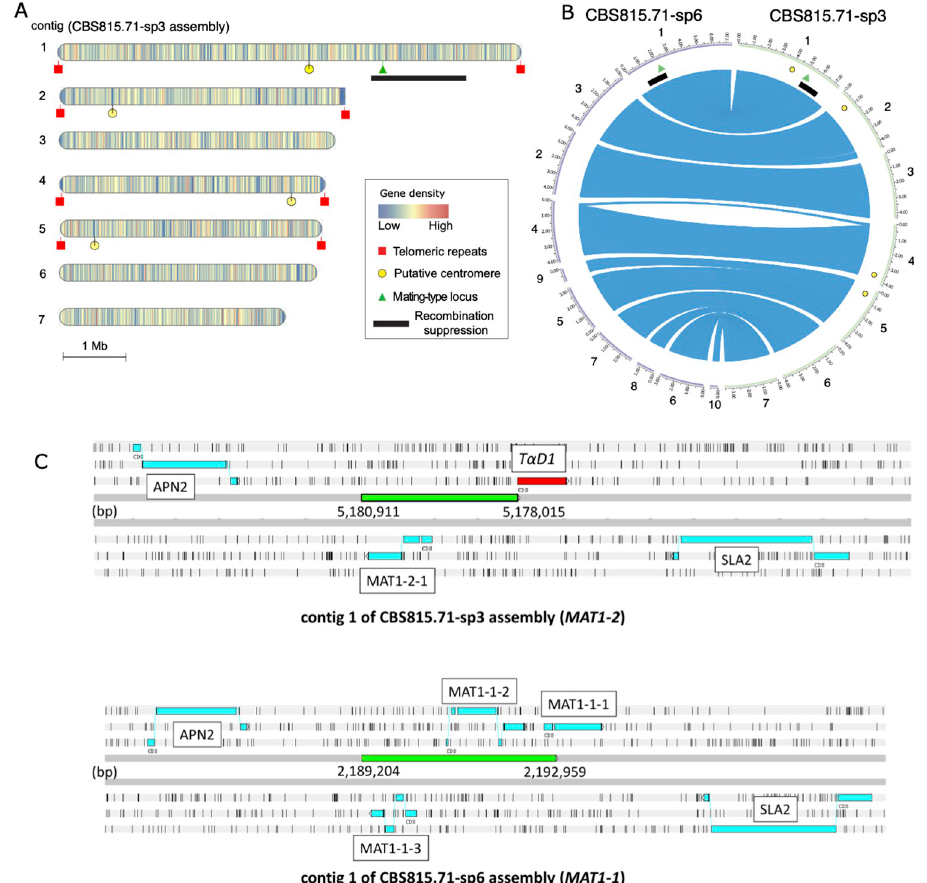
Fig 4. Genome features and annotation of the mating-type locus in the Schizothecium tetrasporum CBS815.71 strain. A. Ideograms representing the seven largest contigs of the CBS815.71-sp3 genome assembly. The mating-type locus is indicated with a green triangle, telomeric repeats with red boxes and putative centromeres with yellow circles. Gene density in 10 kb non-overlapping windows is represented by vertical bars on the contigs and the heatmap colors indicate low to high density. The non-recombining region around the mating-type locus is indicated by a black rectangle. B. Genome collinearity between opposite mating types of the Schizothecium tetrasporum CBS815.71 strain. Circular plot showing contigs from the CBS815.71-sp3 genome (green, right) and the CBS815.71-sp6 genome (purple, left). Only the largest contigs ( > 500 kb) were plotted. Blue links indicate the locations of orthologous genes (Mb). The mating-type locus is indicated with a green triangle. Putative centromeres and the non-recombining region around the mating-type locus identified on the CBS815.71-sp3 genome assembly are indicated by yellow circles and a black rectangle, respectively. C. Organization of the mating-type locus in CBS815.71-sp3 (top, MAT1-2 ) and CBS815.71-sp6 (bottom, MAT1-1 ) assemblies viewed in Artemis v18.0.2 [125]. The APN2 and SLA2 genes flanking the mating-type locus are indicated. The green boxes represent the nucleotide sequences differing between the two idiomorphs that were used to design markers for assessing mating type in the progeny. Coordinates of the region differing between MAT1-1 and MAT1-2 are indicated on contig 1 of the CBS815.71-sp3 assembly for MAT1-2 and on contig 1 of the CBS815.71-sp6 assembly for MAT1-1 . Contigs 1 of the CBS815.71-sp3 and CBS815.71-sp6 assemblies were assembled on opposite strands but for visualization purpose the same strand of both assemblies is shown on the figure. The MAT1-1-1 pseudogene ( T α D1 ) present in the CBS815.71-sp3 ( MAT1-2 ) genome is boxed in red. The three forward and three reverse frames of the DNA sequence are presented; vertical bars indicate putative STOP